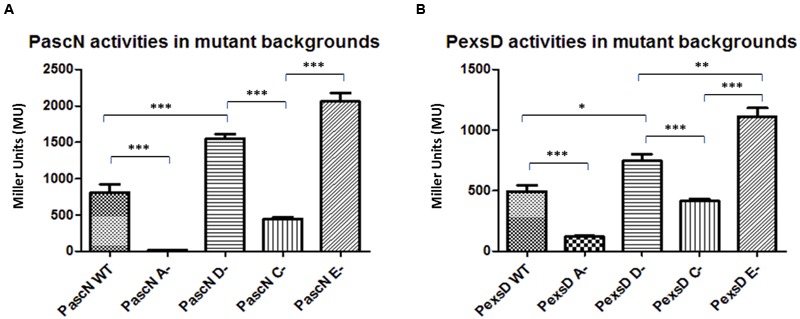
β-galactosidase activities of promoters PascN(A) and PexsD(B) in A. hydrophila AH3R wild type and mutant backgrounds. The promoter activities were measured when each strain was grown in LB broth to log phase at 30°C with shaking at 200 rpm. The promoter activities of PascN and PexsD were significantly decreased in the exsA (A-) mutant and exsC (C-) mutant when compared to the promoter activities in exsD (D-) mutant and exsE (E-) mutant (p < 0.001). Also, the promoter activities in the wild type strain were significantly lower than both the exsD mutant and the exsE mutant strains (p < 0.001). Assays were carried out in triplicate and the values are the means. The error bars showed Standard Error of the Mean (SEM). The graph was created using GraphPad Prism 5. The significance was determined using Student’s t-test (∗p < 0.05, ∗∗p < 0.01, ∗∗∗p < 0.001).